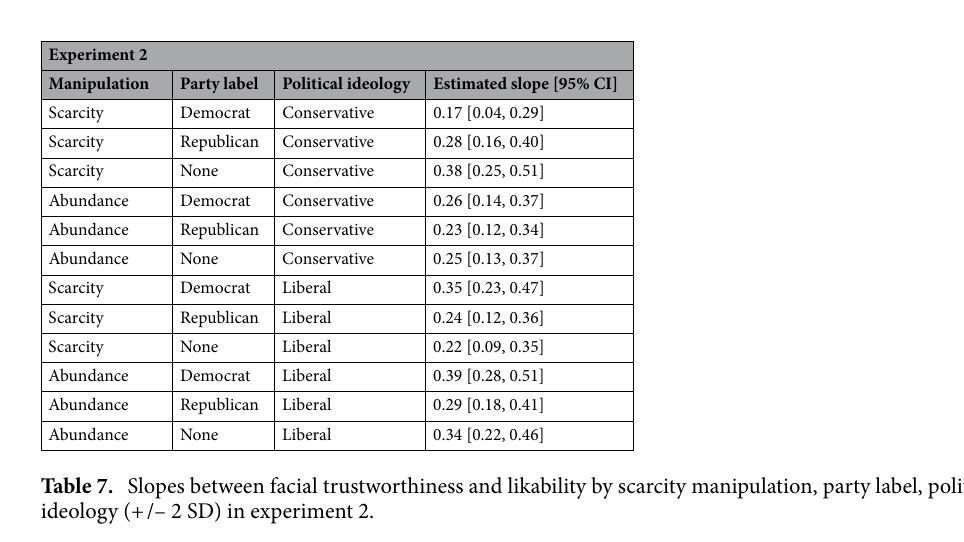
Table 7. Slopes between facial trustworthiness and likability by scarcity manipulation, party label, political ideology (+ /– 2 SD) in experiment 2.